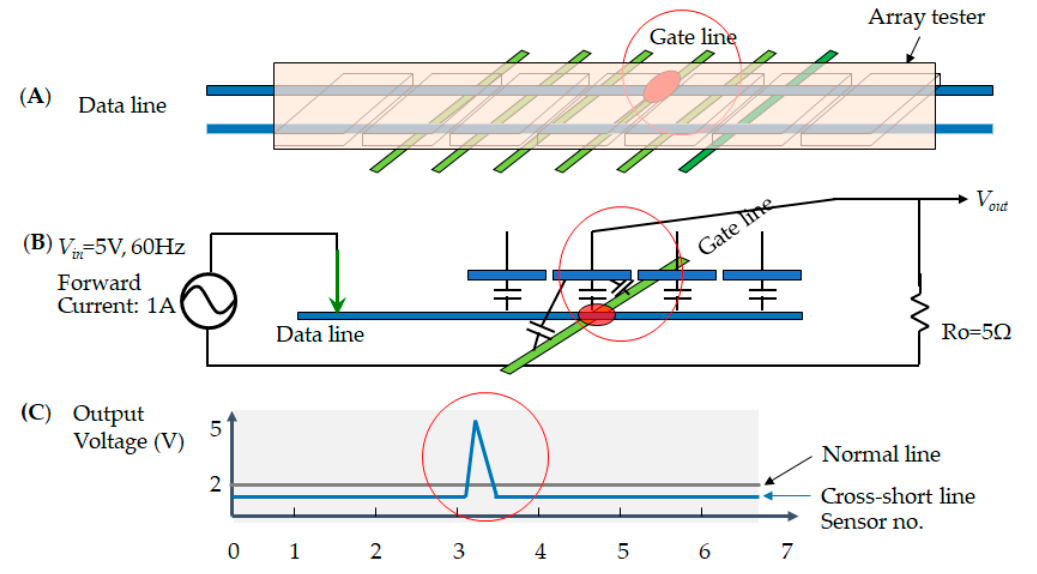
Figure 8. The cross short defect indicates ( A ) the array tester on the glass; ( B ) the electrical current with forwarding voltage; and ( C ) the voltage tendency of the sensor.